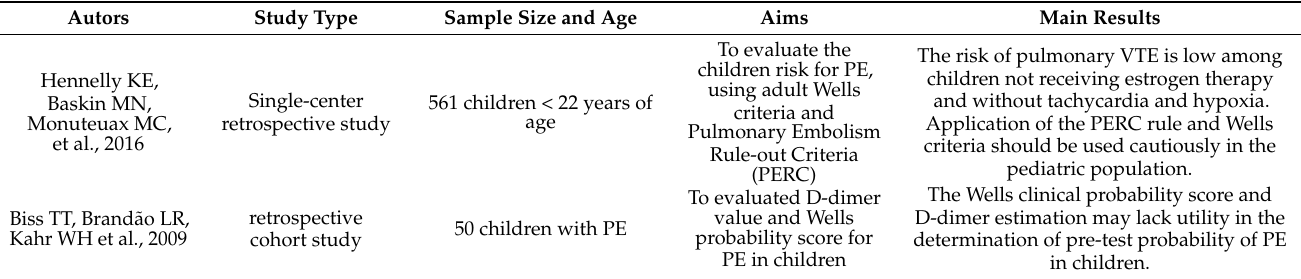
Table 1. Relevant studies depicting the children risk for